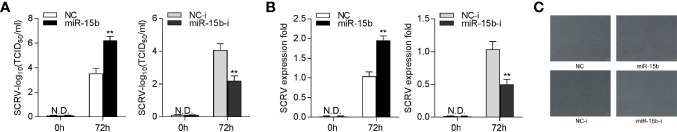
miR-15b promotes SCRV replication. (A) TCID50 assay of the virus replication. MKC cells were transfected with NC, miR-15b, NC-i, or miR-15b-i and infected with SCRV at MOI 5 for 1 h and washed and then added with fresh medium. After 72 h, SCRV TCID50 in cultural supernatants was measured with EPC cells. (B) MKC cells were transfected with oligonucleotides and then infected with SCRV, then the qRT-PCR analysis was conducted for intracellular virus RNA. (C) MKC cells were transfected with NC, miR-15b, NC-i, or miR-15b-i and infected with SCRV. Then, cells were observed for morphological changes. All data are presented as the means ± SE from at least three independent triplicated experiments. **p < 0.01 versus the controls.